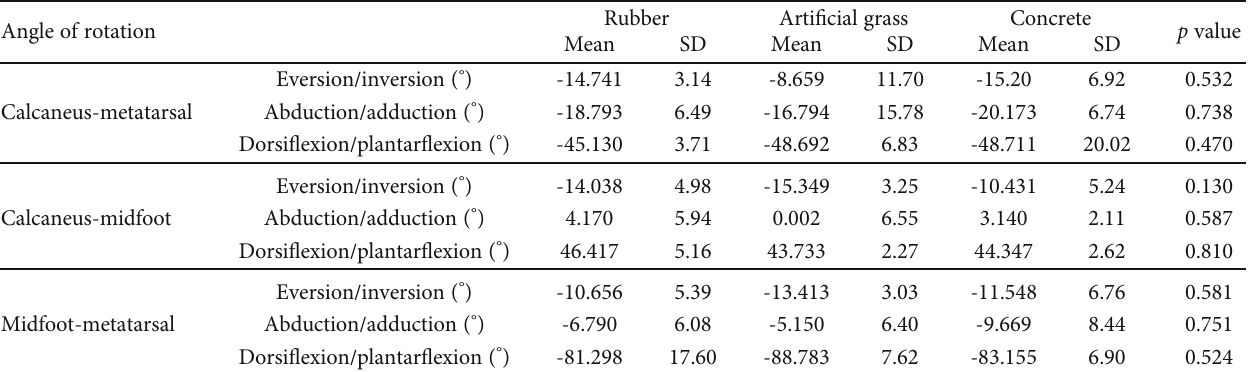
Table 2: Joint rotation during midstance of MS running.